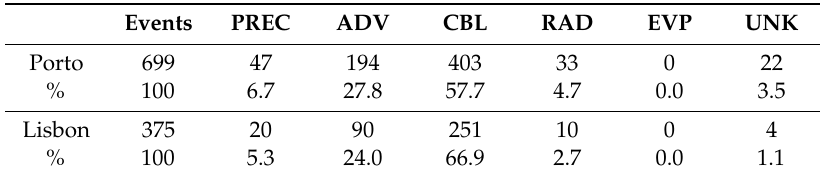
Table 3. Porto and Lisbon fog classification types: precipitation (PREC), advection (ADV), cloud-base lowering type (CBL), radiation (RAD), evaporation fog (EVP) and unknown (UNK). Absolute and percentage values.